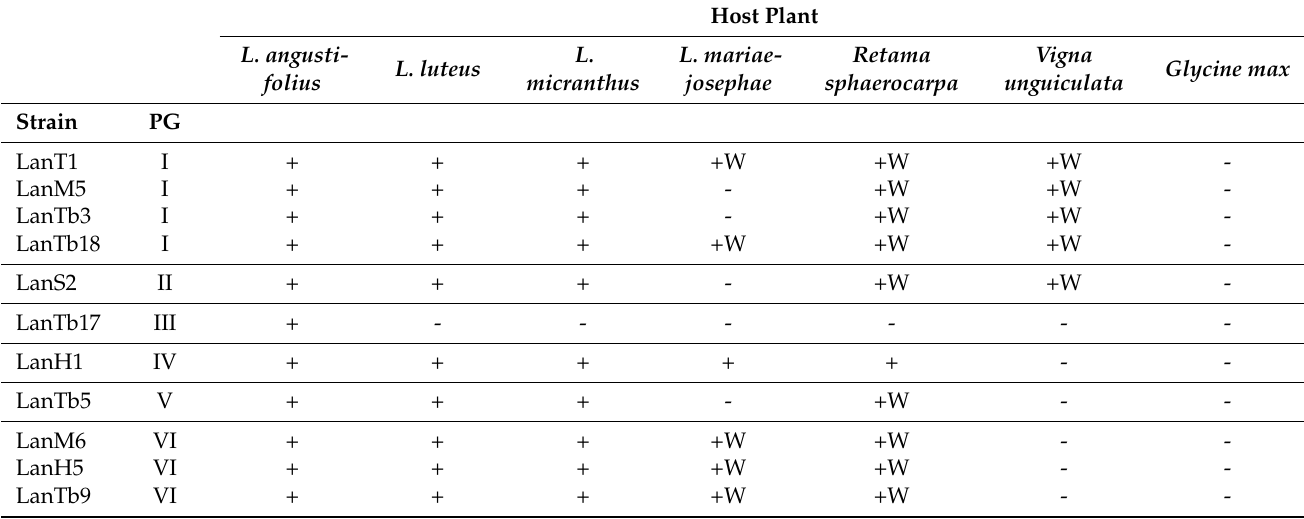
PG: Phylogenetic groups identified in Figure 1. Color of nodules: (+) red, (+W) white, (-) no